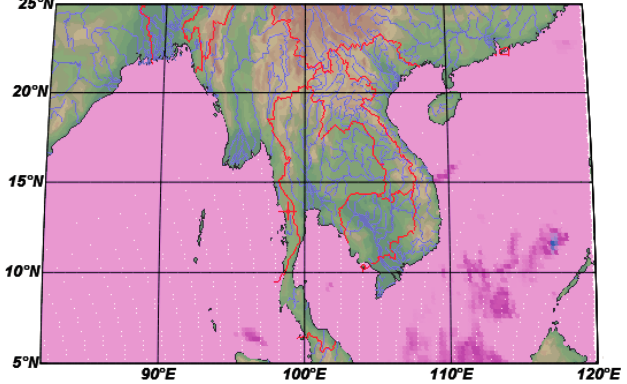
Figure 1. The study domain, defined as the Indochina